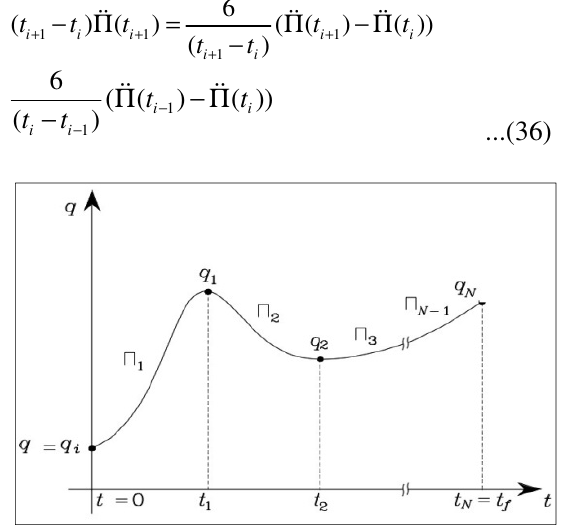
Fig. 4. Cubic Spline Interpolated Trajectory [12] .